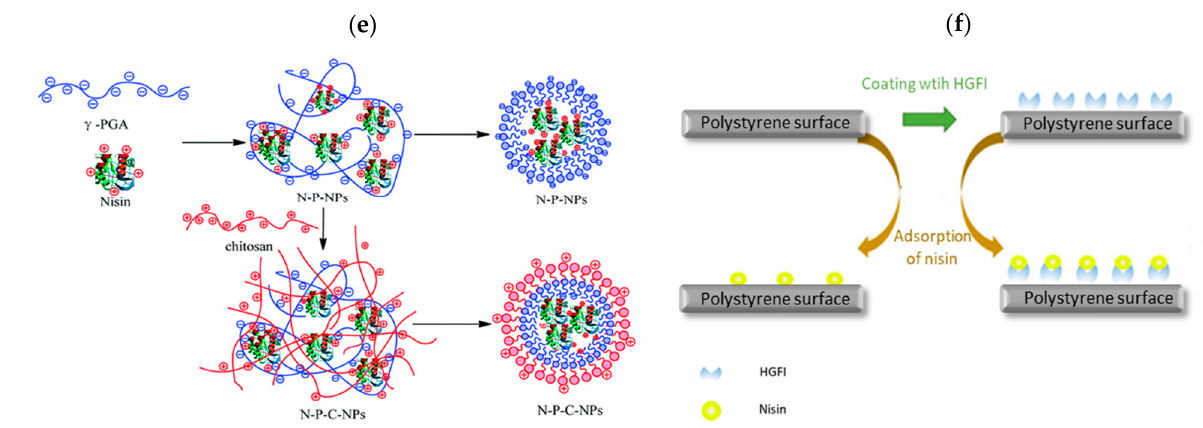
Figure 11. Schematic illustration of immobilization methods of nisin: ( a ) covalent immobilization onto multi-walled carbon nanotubes with PEG 1000 as a linker and hexamethylene diisocyanate as a crosslinking agent (Adopted with permission from [176], RSC, 2011); ( b ) co-culture fermentation of nisin-producing ( Lactococcus lactis N8) and bacterial cellulose-producing ( Enterobacter sp. FY-07) bacteria (Adopted with permission from [153], Elsevier, Amsterdam, The Netherlands, 2021); ( c ) covalent immobilization onto plasma-treated, EDC/NHS ester functionalized polystyrene sheets (Adopted with permission from [138], RSC, 2017); ( d ) covalent immobilization onto plasma-treated polystyrene sheets (Adopted with permission from [138], RSC, 2017); ( e ) nisin loaded chitosan-poly- γ -glutamic acid nanoparticles (encapsulation) (Reproduced with permission from [179], RSC, Cambridge, UK, 2016); ( f ) adsorption of nisin on blank and HGFI-coated polystyrene surface together with antimicrobial activity of both surfaces (Adopted with permission from [9], Elsevier, Amsterdam, The Netherlands, 2021).